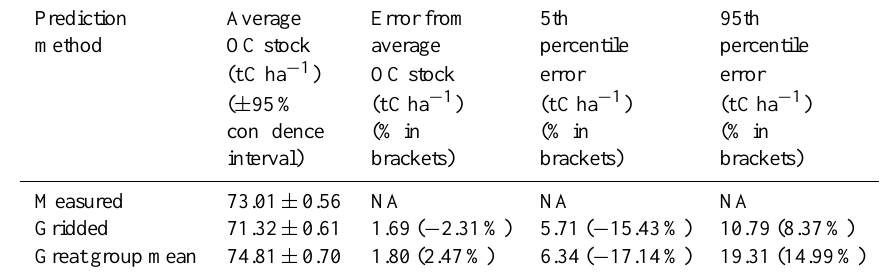
Table 3. Point estimates of OC stock. Average stock was calculated using Eq. (4). Of the prediction methods, “Measured” uses measured D b values, “Gridded” uses the gridded predicted D b values, and “Great group mean” uses the measured mean D b per soil great group.